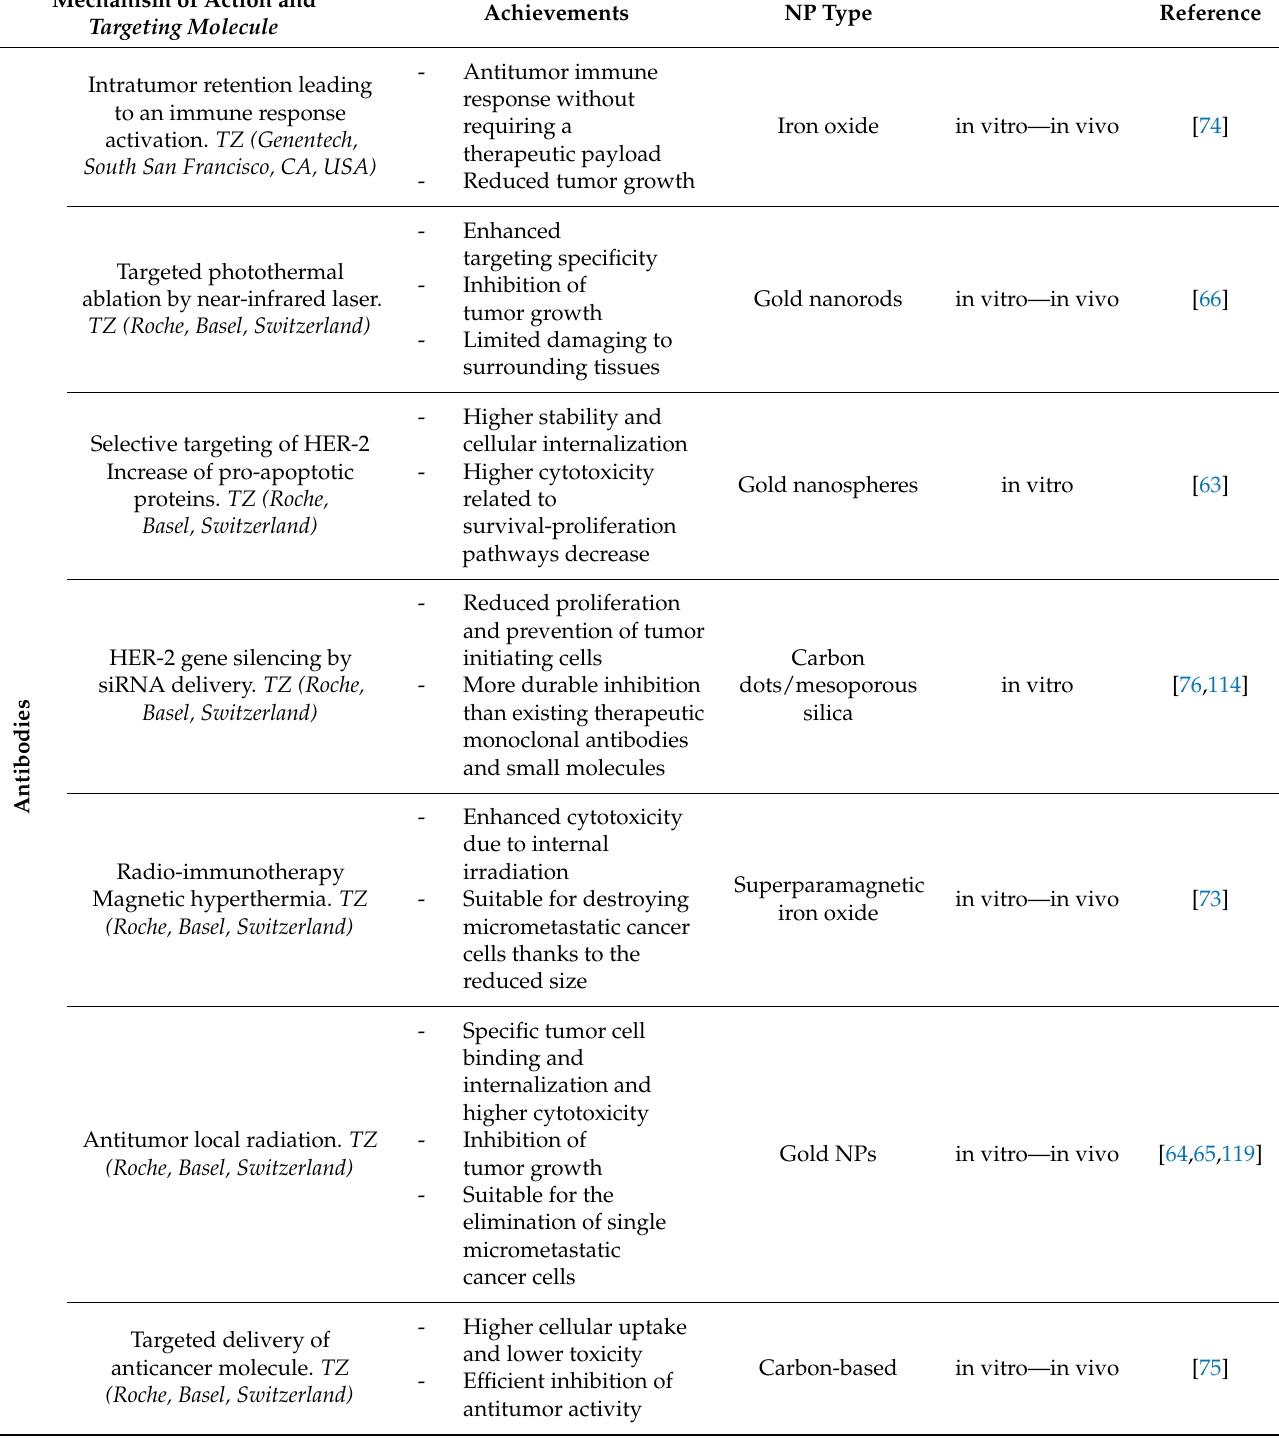
Table 2. Summary of all significant examples of inorganic NPs developed for HER-2 + BC